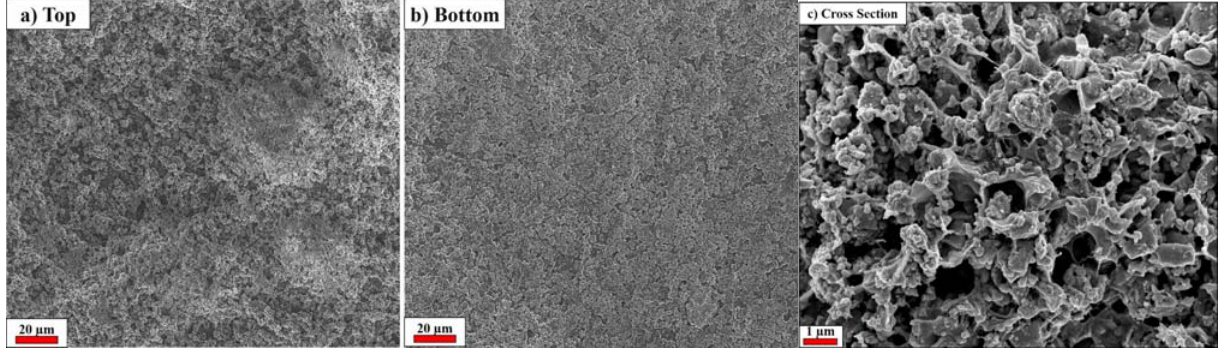
Figure 2. SEM pictures of the SiO 2 –HPG membrane. ( a ) Top face (air contact at drying step); ( b ) Bottom face (PTFE contact at drying step); ( c ) Cross